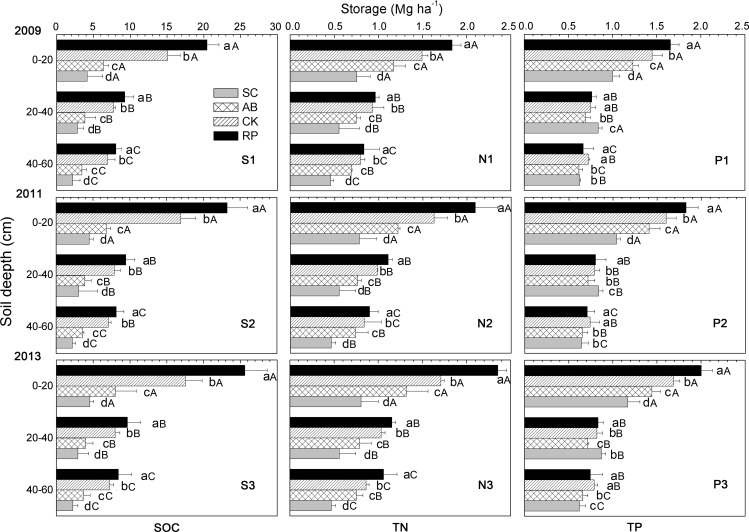
Soil storage of SOC, TN, and TP of different land use types and soil depth in 2009, 2011, and 2013.Columns with different capital letters indicate significantly difference among different soil depth in same land use types; columns with different small letters indicate significantly different of among different land use types in same soil depth. All significances are been tested at P<0.05 level of probability. Error bars represent standard errors.